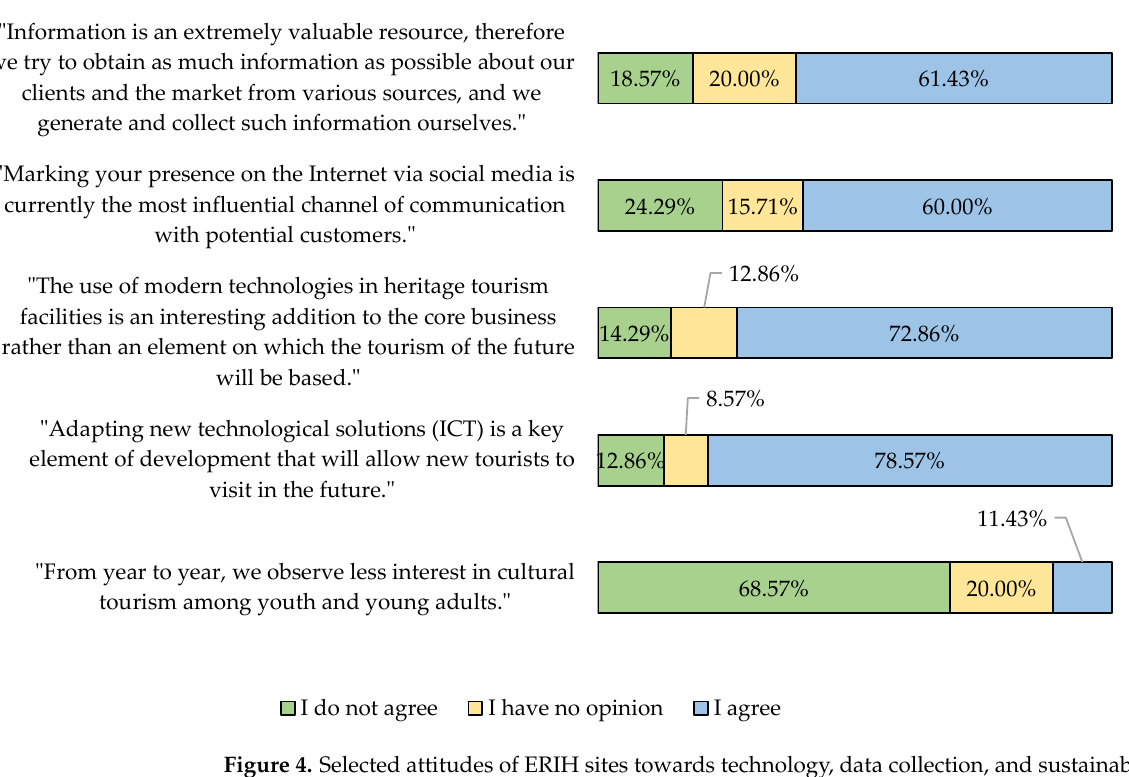
Figure 4. Selected attitudes of ERIH sites towards technology, data collection, and sustainability.